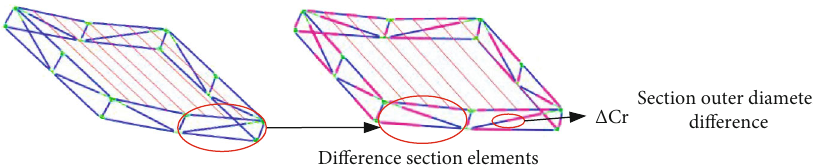
Figure 10: The super element composed of two di ff erent sections of carbon fi ber tube